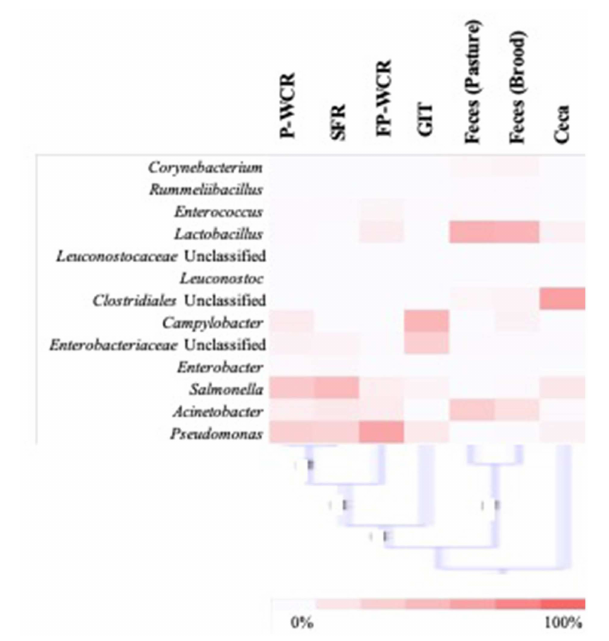
FIGURE 5 | Analysis of the stringent core poultry-related microbiome, representing 13 taxa that were present in 75% of all samples along the farm-to-fork continuum of a pasture-raised broiler flock. The distribution of these taxa within each sample type/stage of the farm-to-fork continuum are shown by the heatmap (with higher concentrations denoted by darker red color), and WPGMA below the heatmap indicating the relatedness of the stringent core microbiomes within the different sample